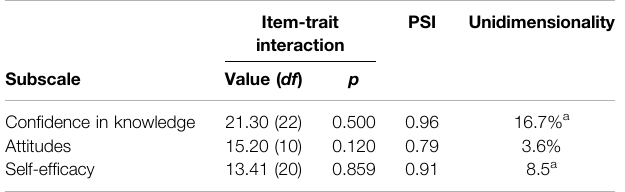
PSI, person separation index . For Item-Trait Interaction: p < 0.05 is statistically signi fi cant. a Unidimensionality > 5% suggests potential multidimensionality. These results were obtained after mis fi tting items were removed. Data is derived from a sample of 159